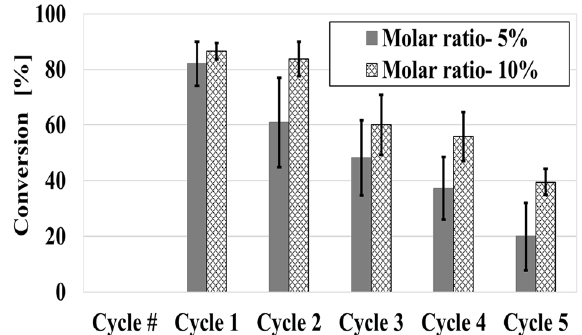
Figure 4. Matrix conversion as a function of the molar ratio and the number of cycles when reaction time is 1 h, in toluene. Sol–gel matrix was prepared TEOS at pH 12, Catalyst B. RCM of DDM reaction 1 conditions: Molar ratio (between the catalyst and the substrate): at molar ratio 5% catalyst initial = 1.0 . 10 –6 mol or at molar ratio 10% catalyst initial = 2.0 . 10 –6 mol; Reaction time: 1